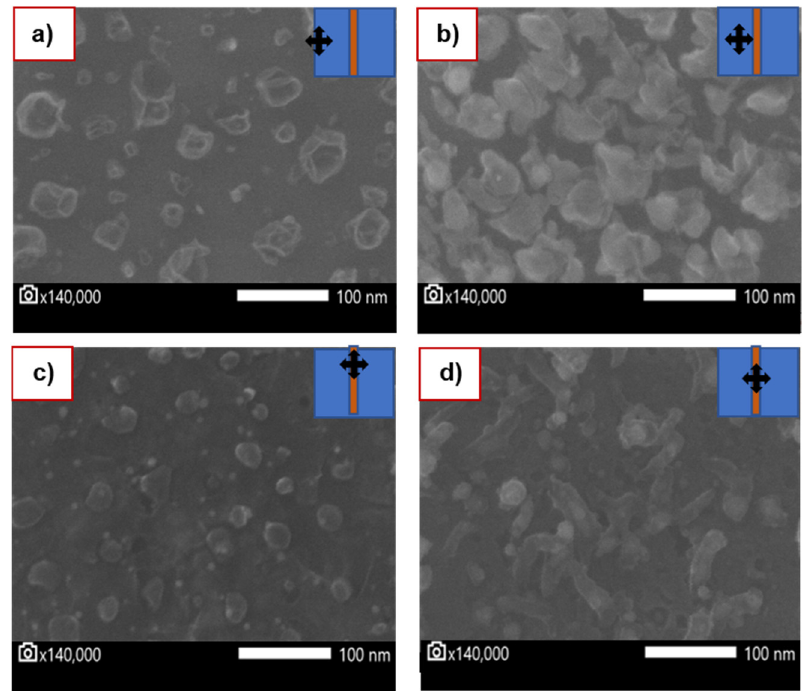
Figure 4. SEM measurements of the graphene growth on SiO 2 /Si substrate: ( a ) and ( b ) show the SEM image taken in two areas next to the copper-strip at 140,000×. Similarly, ( c ) and ( d ) show two areas on top of the copper strip at the same magnification. In all cases, crossed arrows represent the position relative to the copper strip where the image was taken.